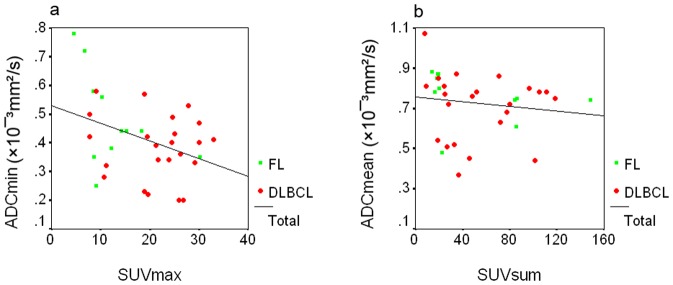
Scatter plots showing the correlations between the SUVmax and ADCmin, (a), and between the SUVsum and ADCmean (b) in 34 patients with DLBCL or FL.The SUVmax correlated inversely with the ADCmin (r = −0.35, p<0.05) (Figure 3a), and the SUVsum correlated inversely with the ADCmean (r = −0.42, p<0.05) (Figure 3b) in all cases.